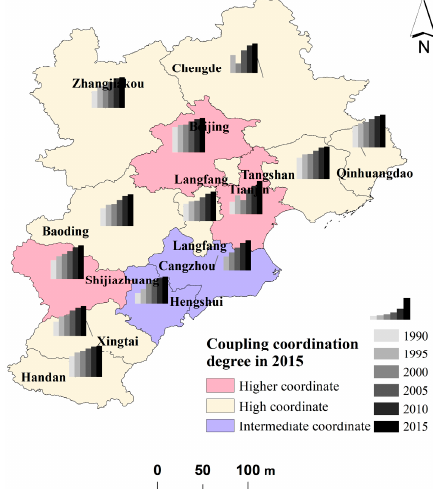
Figure 10. The spatio-temporal patterns of the coupling coordination degree of the thirteen cities in the Beijing-Tianjin-Hebei region (1990–2015).